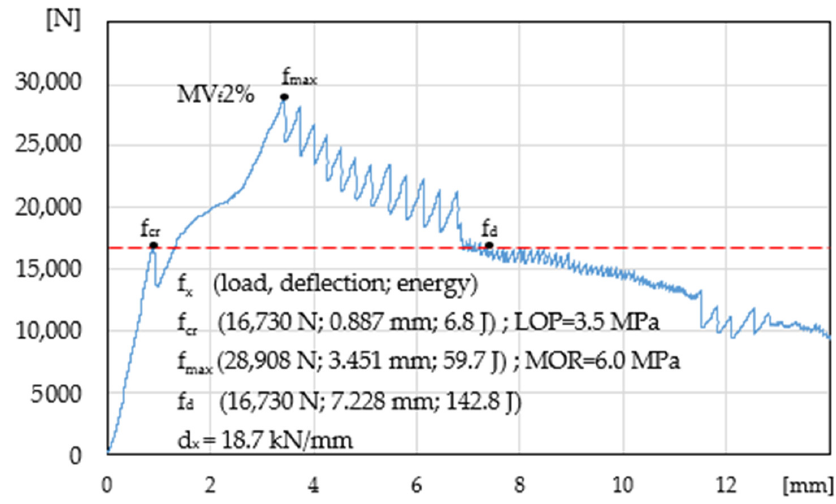
Figure 5. Load-deflection curve in the four-point bending test, mortar MV f 2%.